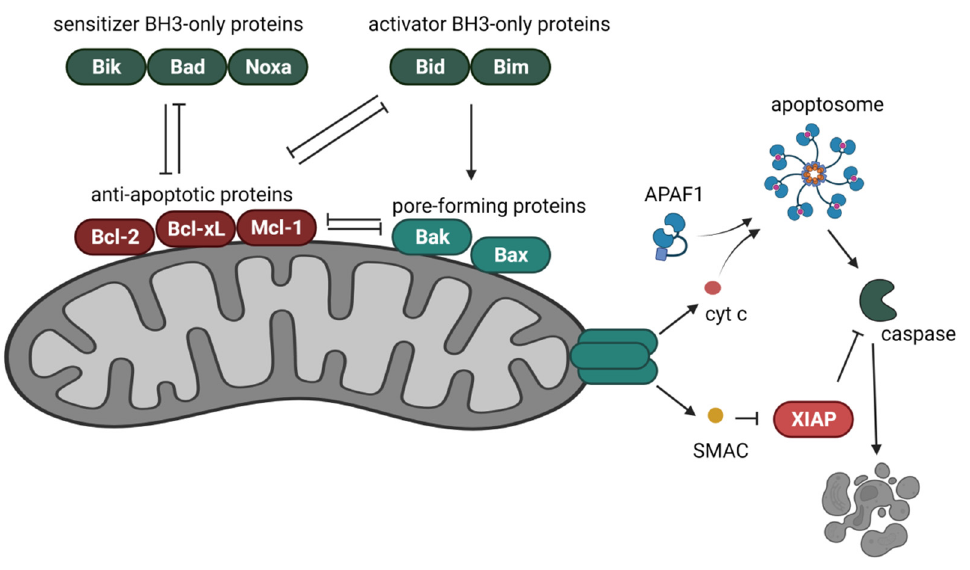
Figure 3. Bcl-2 family of proteins and their role in the intrinsic apoptotic pathway. The anti-apoptotic proteins (Bcl-2, Bcl-xL, Mcl-1) inhibit the activity of the pro-apoptotic proteins. The